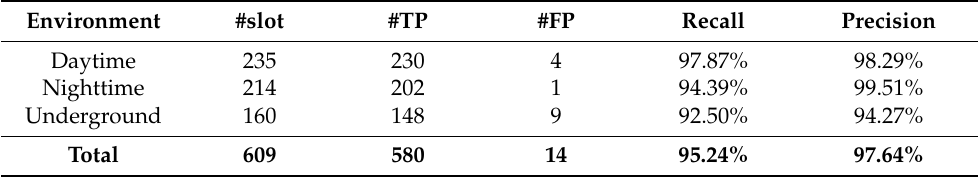
Table 2. Parking slot recognition performance of the proposed